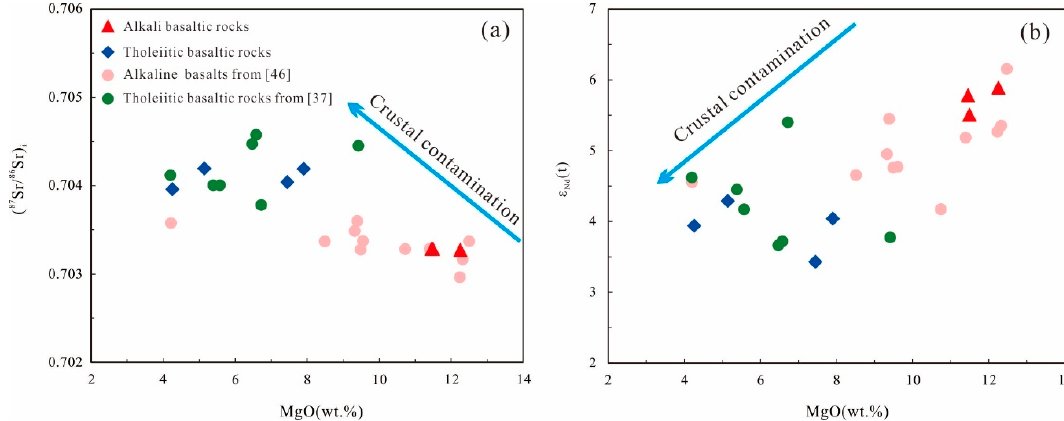
Figure 12. ( a ) Diagram of ( 87 Sr / 86 Sr) i versus MgO and ( b ) diagram of ε Nd (t) versus MgO for the identification of continental contamination.